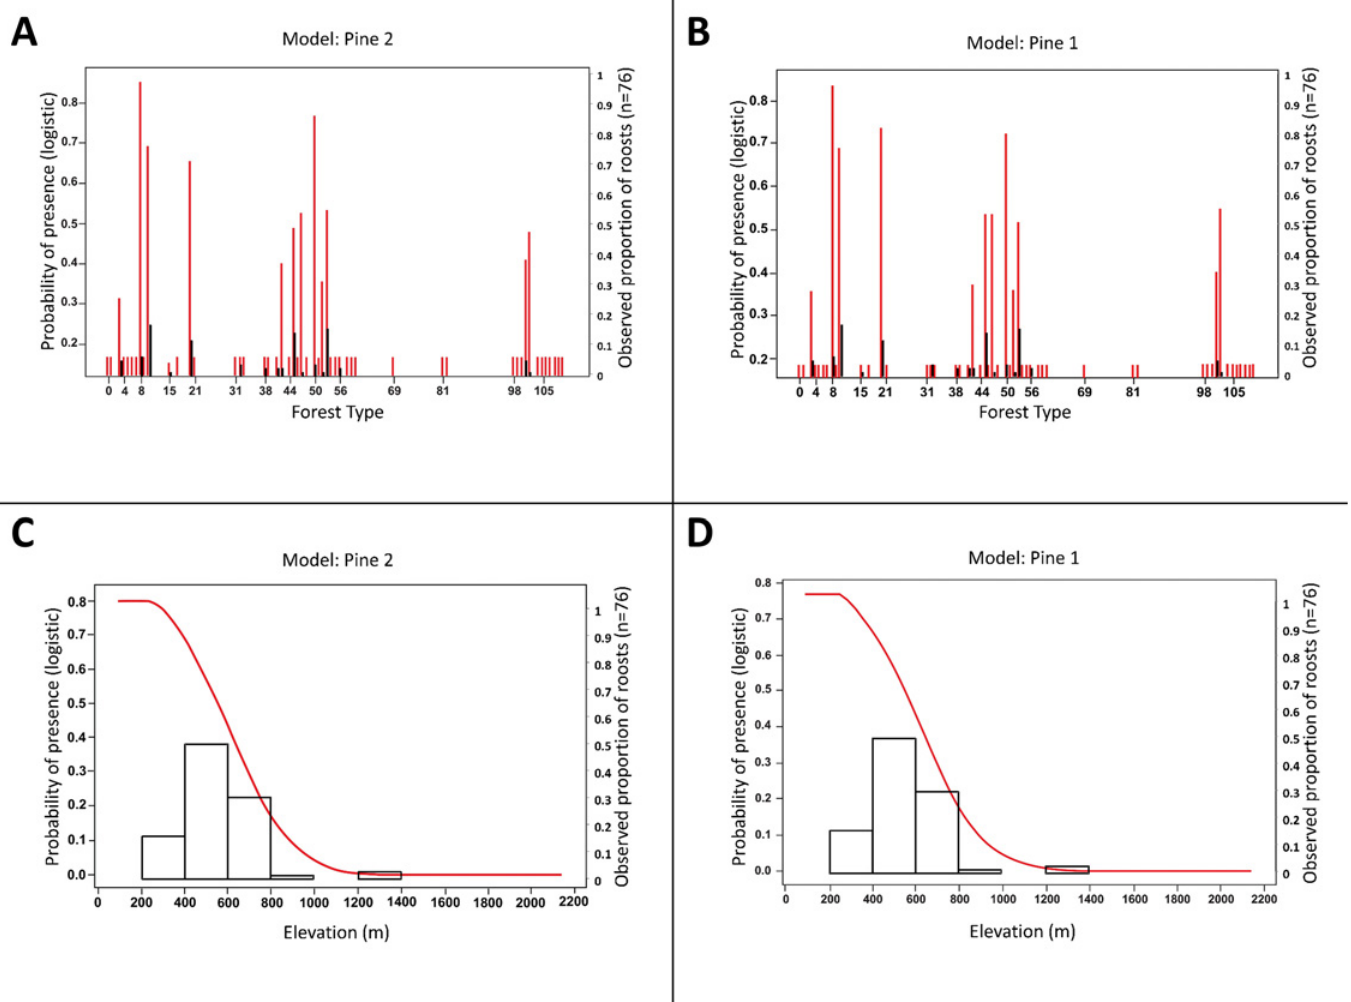
Fig 2. Response curves (red) for forest type (A, B) and elevation (C, D) for top-performing models . The observed proportions of roosts in each forest type or elevation class are plotted as black bars on secondary axes. The best models, Pine 2 and Pine 1, were developed using a subset of 54 female